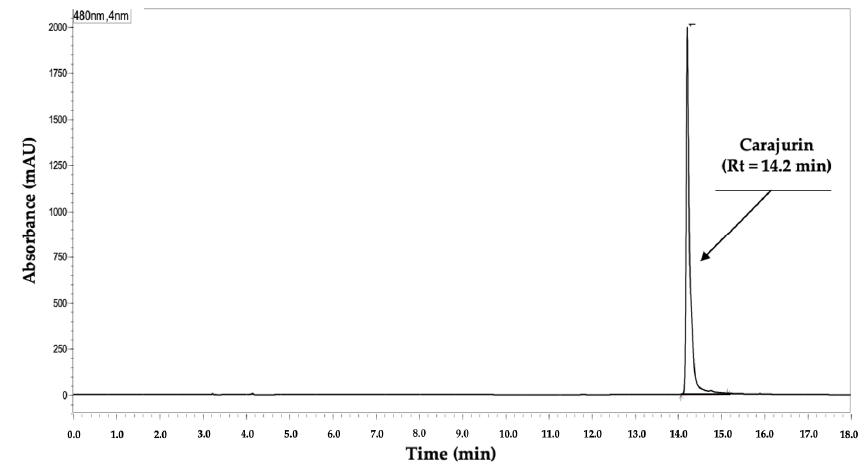
Figure 2. Chromatogram of carajurin solution (100 µ g/mL) at 480 nm.